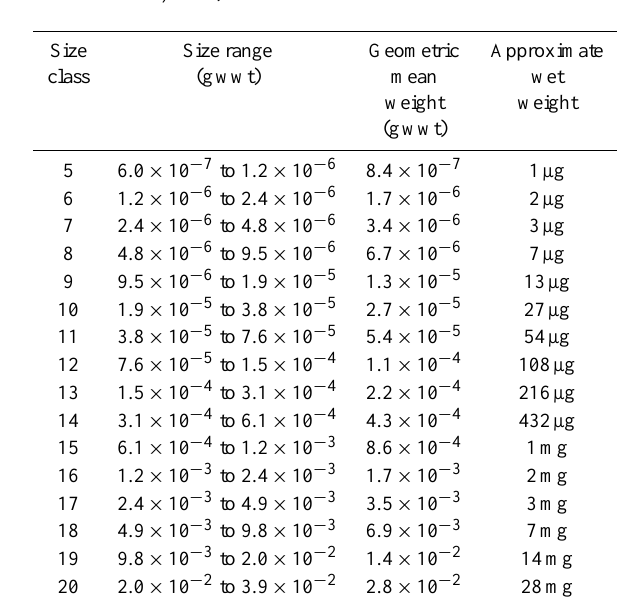
Table 2. Geometric body size classes used in this study (adapted from Warwick,